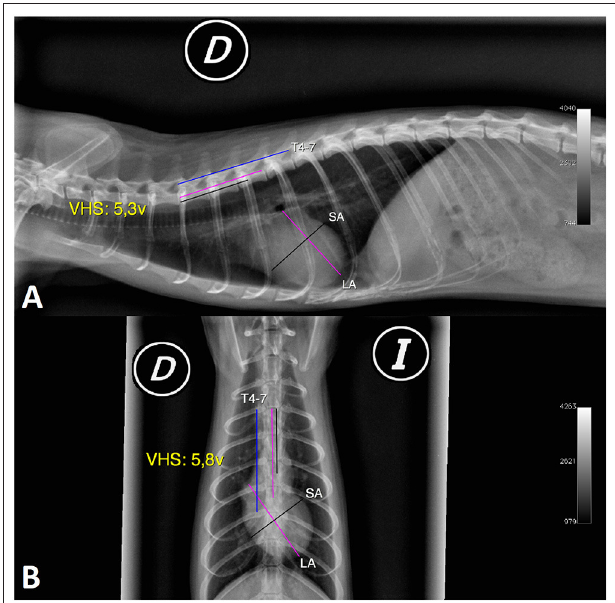
FIGURE 1 | Radiographic image in the right lateral (RL) and ventrodorsal (VD) projections of the normal thorax of a female ferret (A,B) . X-rays show measurements of the cardiac silhouette. Long axis of the cardiac silhouette (LA), short axis of the cardiac silhouette (SA), vertebral body length from T4 to T7 (T4–7), and vertebral heart scale (VHS) (D, right; I, left).